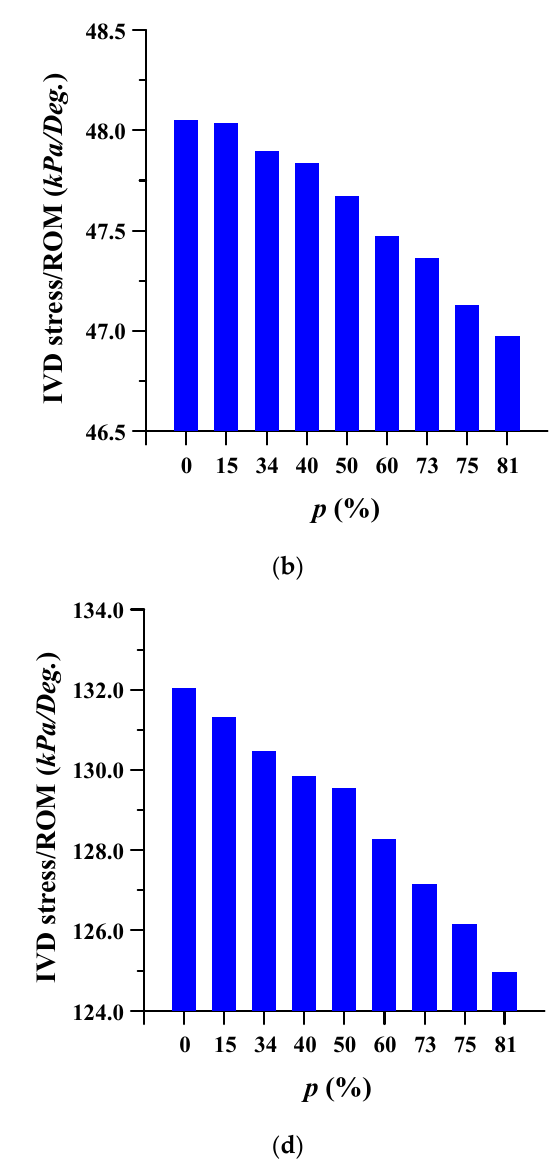
Figure 8. Equivalent stress per range of motion (ROM) of adjacent intervertebral disc (IVD) of L3-4 at different porosities of the spinal implants in each spinal motion: ( a ) flexion; ( b ) extension; ( c ) lateral bending; and ( d ) rotation.